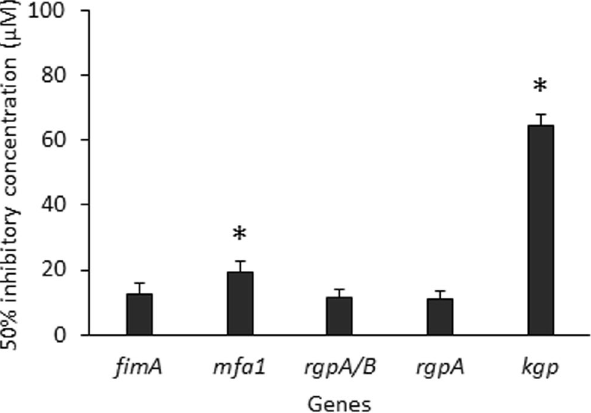
Figure 5. Potency of peptide4 for inhibition of virulence gene expression in P . gingivalis . The half inhibitory concentration (IC50) was measured by conducting three independent experiments to determine mRNA levels of fimA , mfa1 , rgpA / B , and kgp in the presence of peptide4 at the concentrations 0, 4, 16, and 64 µ M, respectively. The IC50 for each gene was established using a Microsoft Excel program with add-in for curve fitting. Asterisks indicate the statistical significances of IC50 of peptide4 for a specific gene when compared to that for the fimA gene ( P < 0.05; t